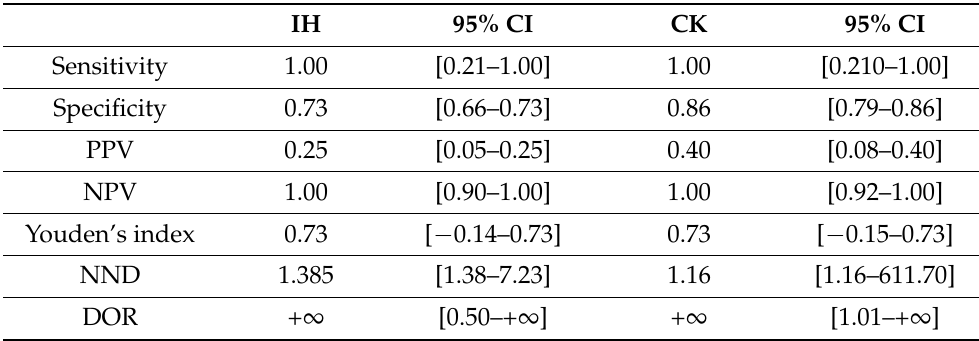
Table 5. Diagnostic indices of the IH and CK-PCR assays on ( n = 24) skin samples compared to conventional methods as the gold